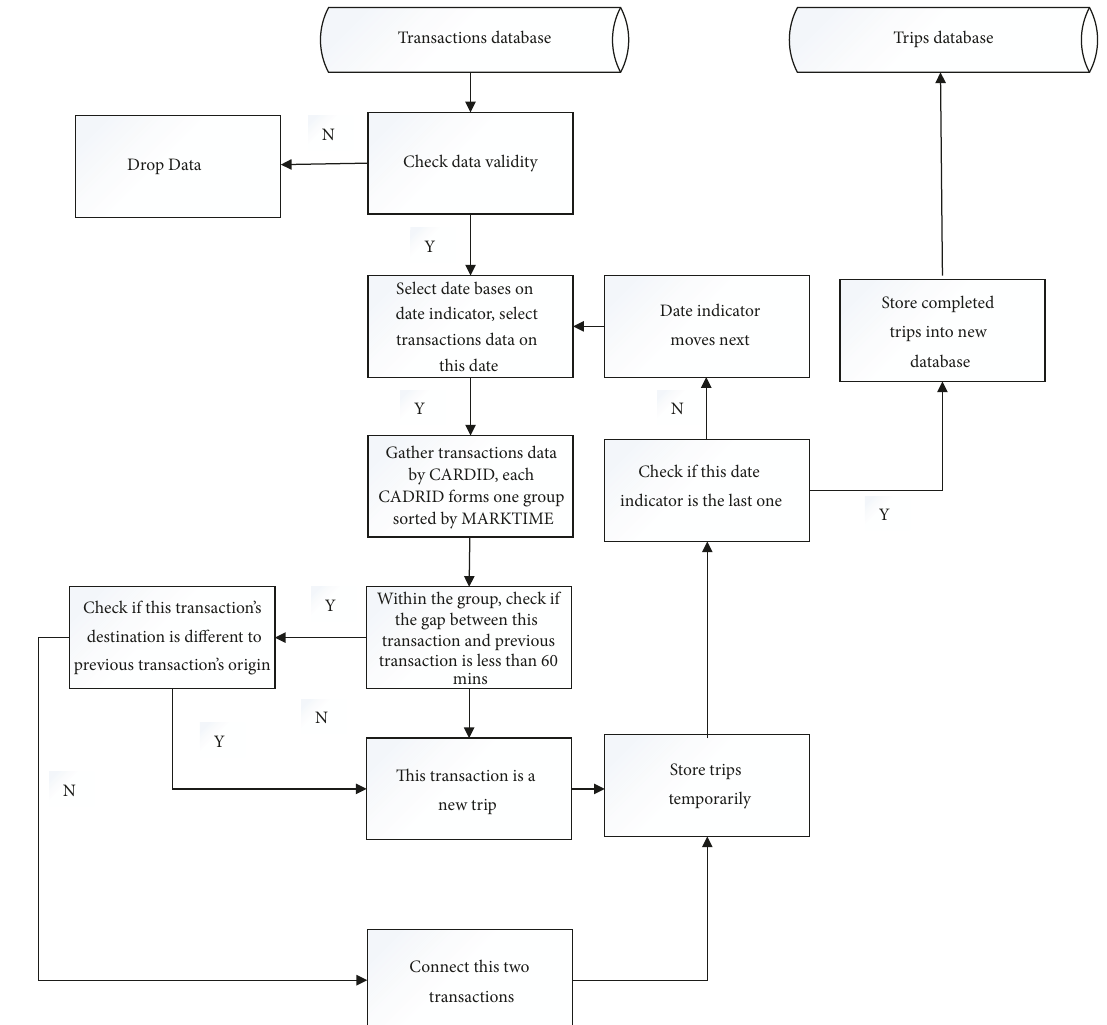
Figure 1: Trip reconstruction